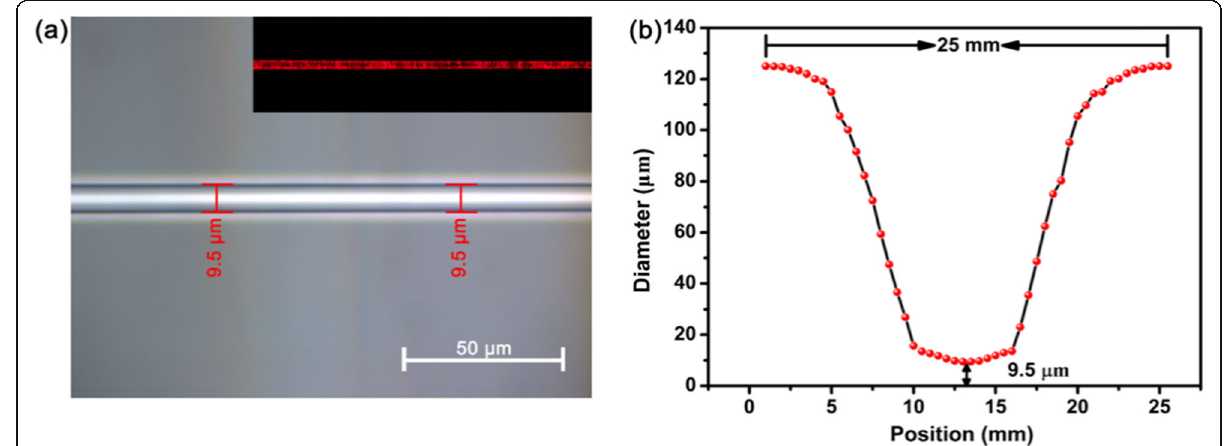
Fig. 2 a Microscopic image of the fabricated MF. b Morphological characteristic of